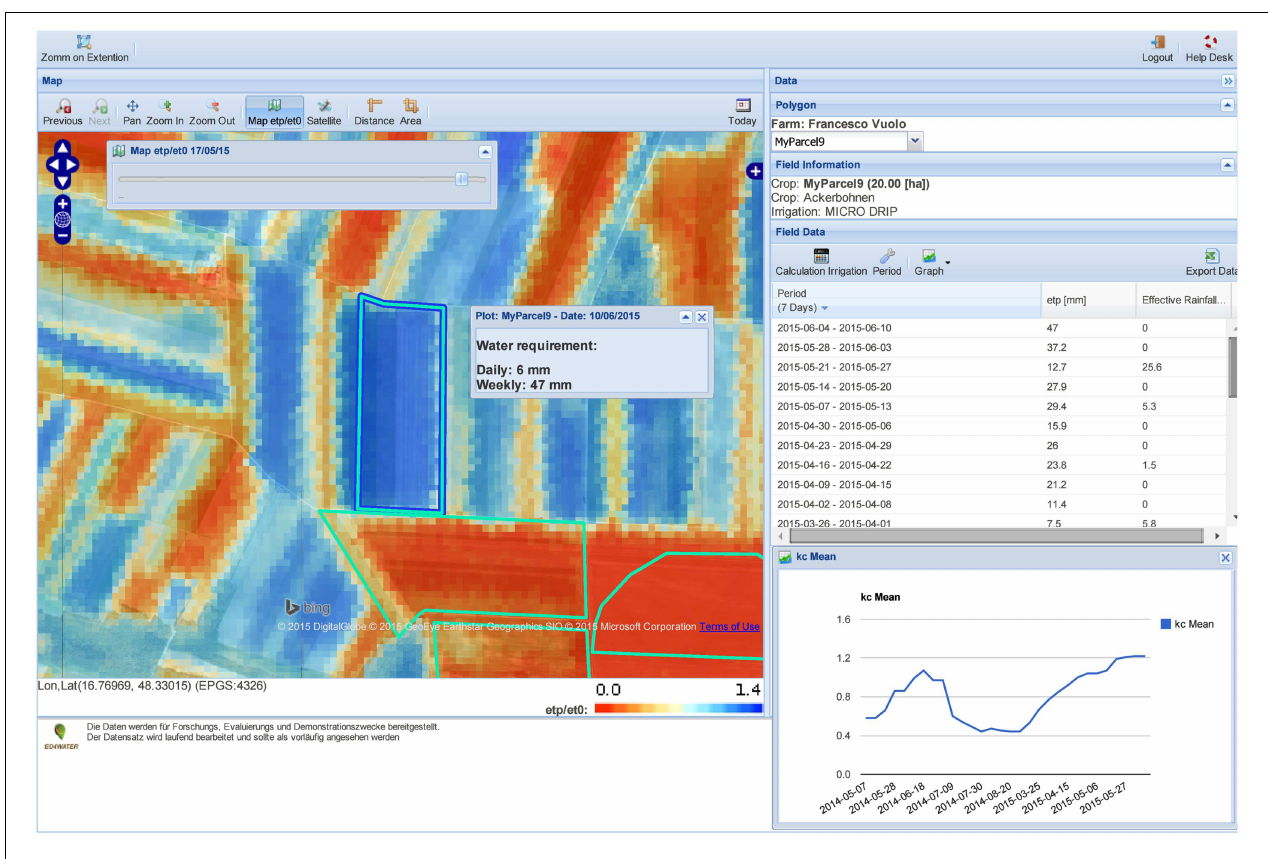
k c -values); the data and chart panel on the right side display the weekly crop ET, the effective rainfall values, and the k c chart of the selected parcel.